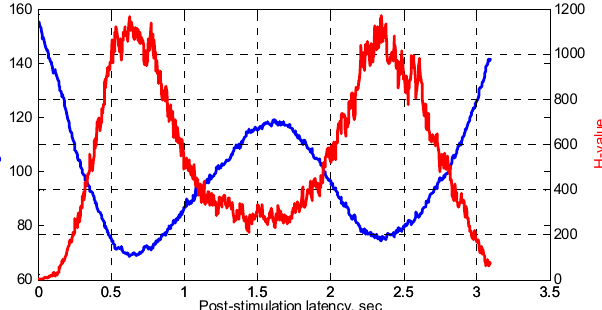
Figure 11. Average distance (blue) and H ‐ values (red) evaluated for male participants and for all EEG channels as a function of post ‐ stimulation latency.